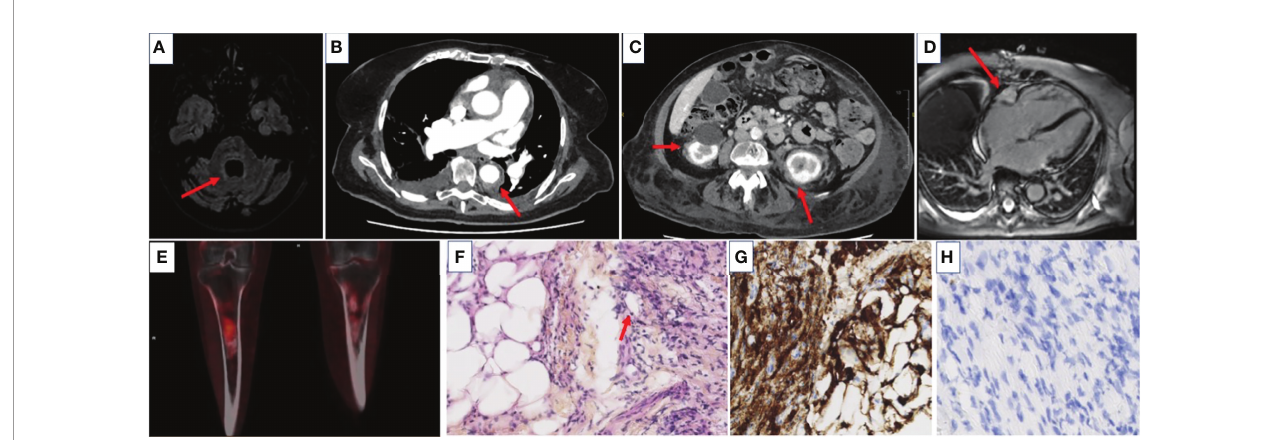
FIGURE 1 | Radiological and histological features of the patient suffering from Erdheim – Chester disease (ECD) at diagnosis. (A) Axial brain MRI showing hyperintense signal in the pons on T2-FLAIR sequence. (B) Axial CT scan showing sheathing of aorta adventitia. (C) Axial CT scan showing bilateral perinephric fat in fi ltration de fi ned as “ hairy-kidney ” . (D) Axial heart MRI showing a right atrium mass suggestive of a pseudo-tumor. (E) Sagittal 18 F fl uorodeoxyglucose positron emission tomography demonstrating radiotracer uptake in meta-diaphysis. (F) Histopathological analysis of a CT scan-guided peri-renal adipose tissue biopsy showing massive in fi ltration by numerous foamy histiocytes and small lymphocytes, with features of cyto-steatonecrosis (HES, magni fi cation ×300). (G) Similar biopsy sample with immunostaining showing CD163-positive histiocytes (brown staining, magni fi cation ×300). (H) Sample biopsy showing the absence of CD1a-positive cells (brown staining, magni fi cation